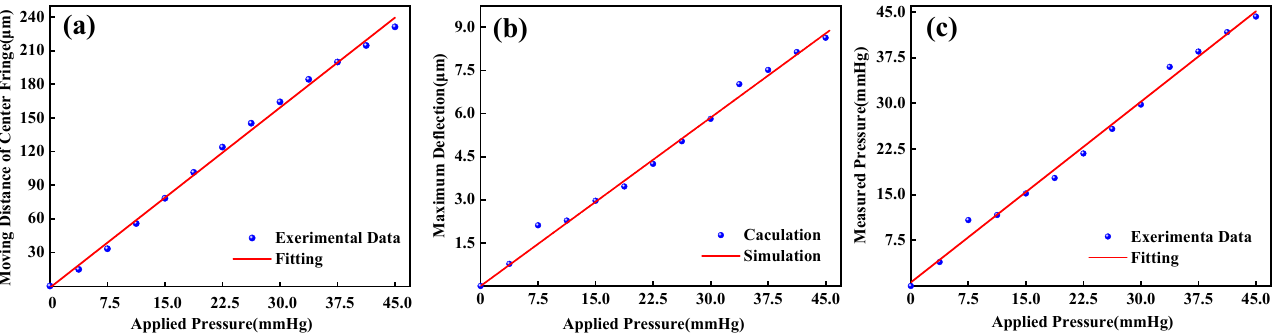
Figure 7. ( a ) Moving distance of center fringe as a function of applied pressure. ( b ) Maximum deflection of the sensor diaphragm and the ideal curve. ( c ) Measured pressure versus applied pressure using the IOP sensor.